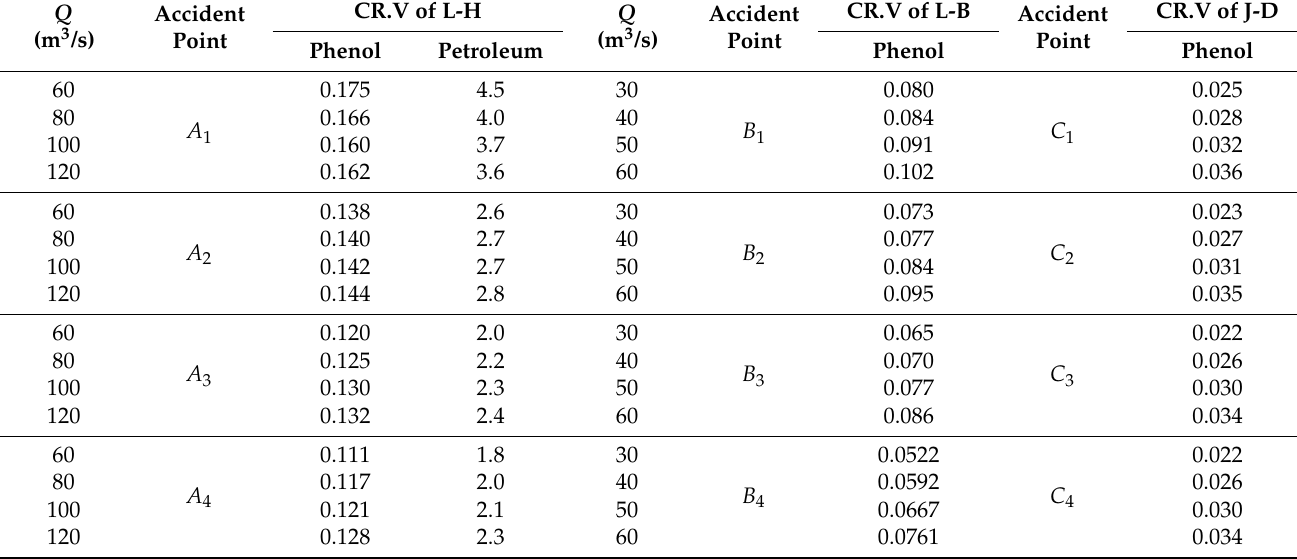
Table 3. Critical values (CR.V) of the main trunk roads (unit: